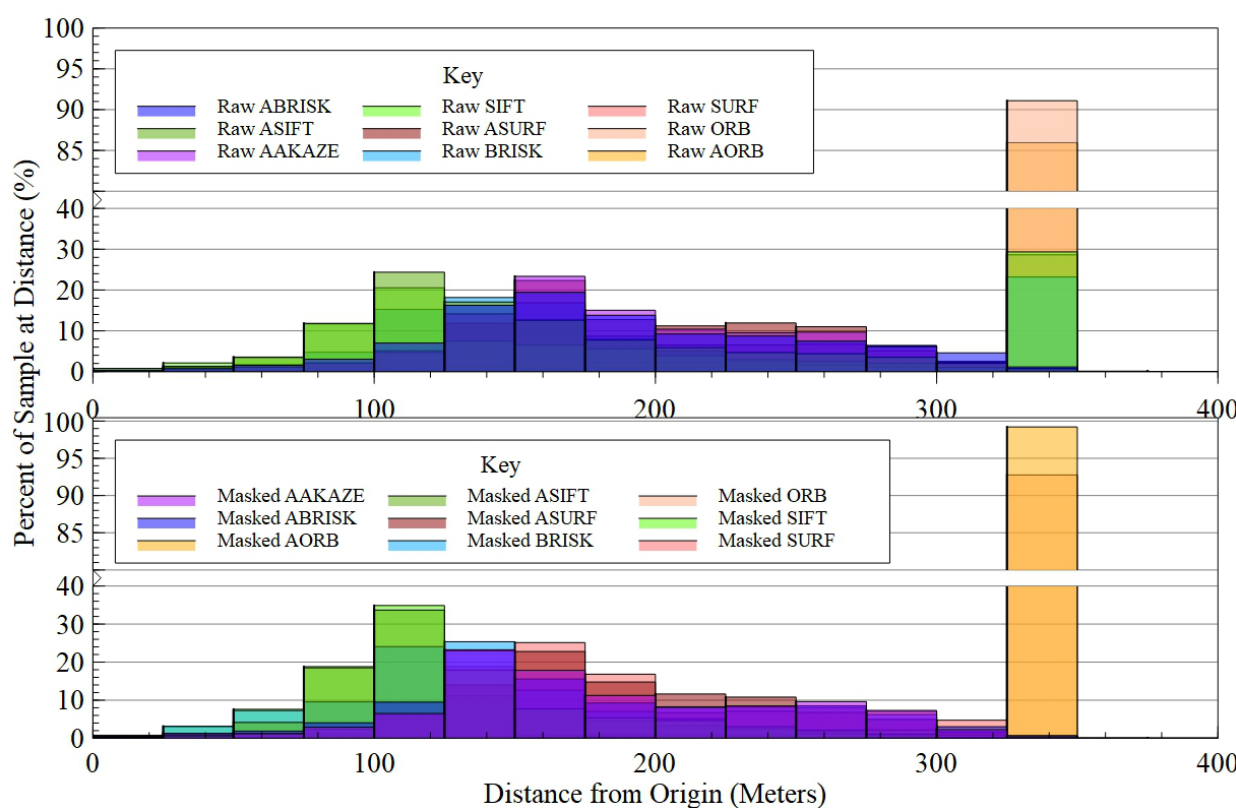
Figure 15. A histogram of distances to ground truth pose computed across the sample. Note that an intentional axis break exists between 40 and 80% to clarify the distribution of lower percentages while still visualizing the